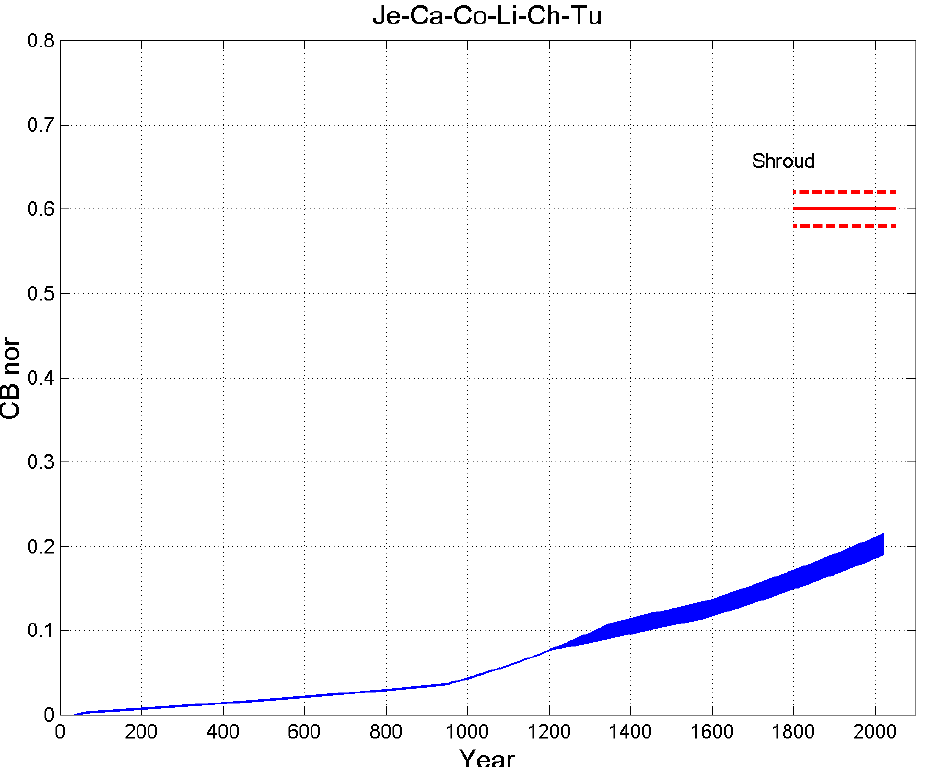
Figure 8. CB nor versus year in the Jerusalem–Camulia–Constantinople–Lirey–Chamb é ry–Turin path4 (Tables 1 and 2, Figure 1) until the year 2021. Each curve assumes a different arrival year in Europe, t Eu , randomly generated from a uniform distribution in the interval 1204 ≤ t Eu ≤ 1354. The upper curve assumes t Eu = 1354, while for the lowest curve t Eu = 1204. In 2021, CB nor , min = 0.190, CB nor , max = 0.225, and CB nor , ave = 0.203. The continuous red line indicates the average experimental CB nor = 0.60 measured for the Shroud [9]; the dashed red lines indicate ± 1 standard deviation bounds due to measurements